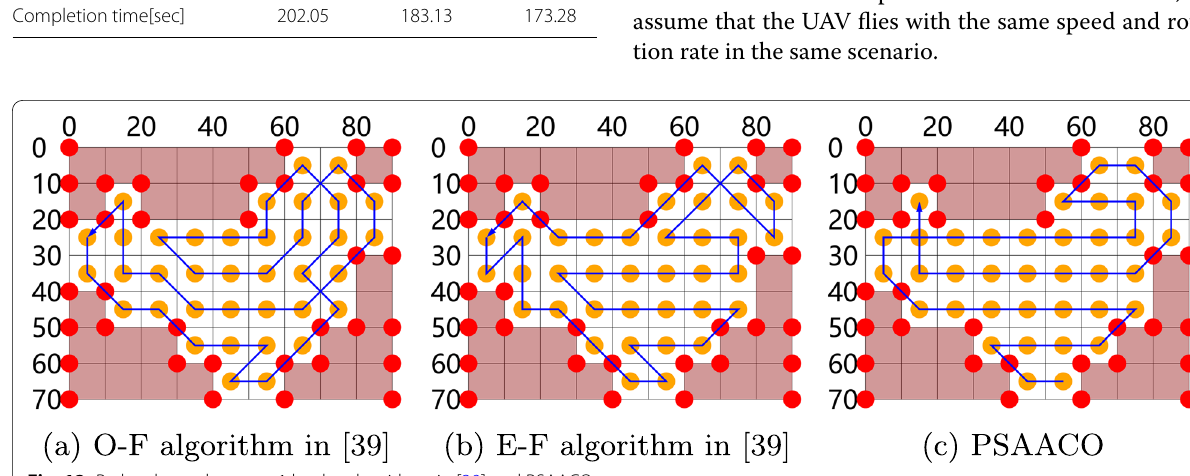
Fig. 12 Paths planned on area 1 by the algorithms in [39] and PSAACO